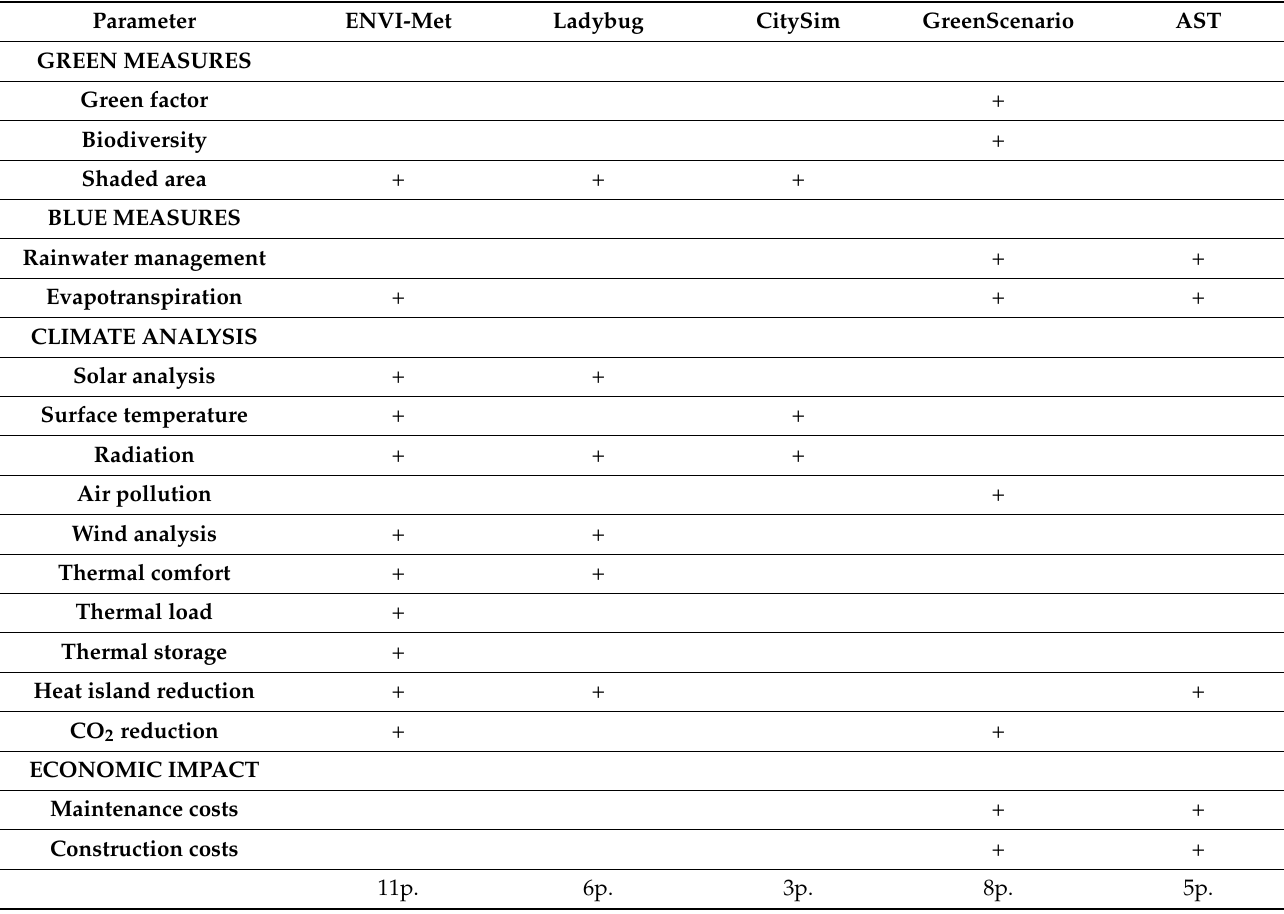
Table 2. Comparison of functional completeness of different software tools (source: authors). Parameter